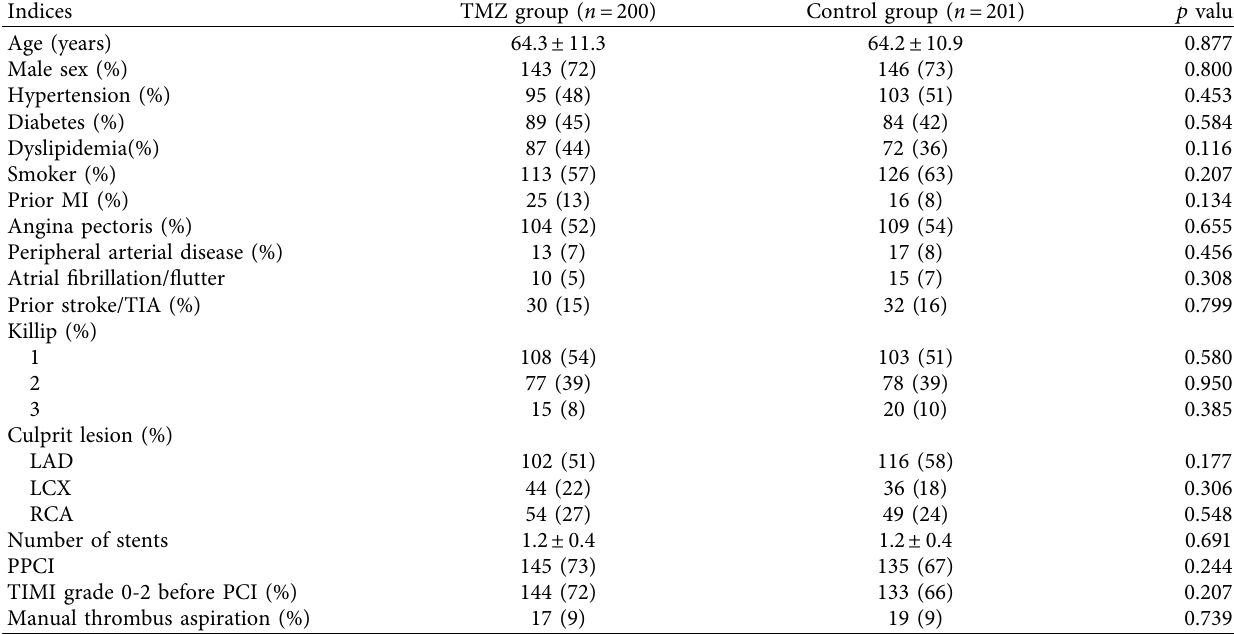
Table 1: Baseline clinical characteristics.